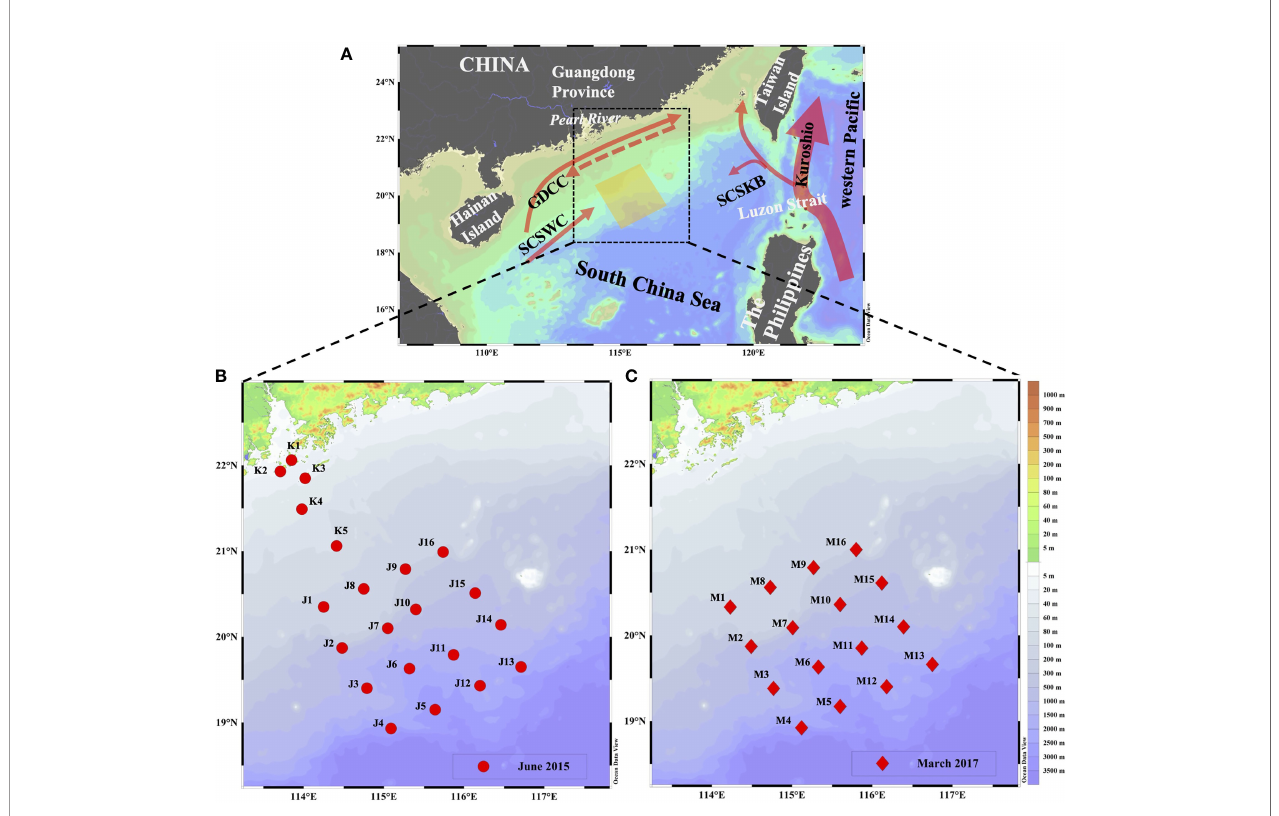
FIGURE 1 | (A) Location of our study area and water currents pattern (Hu et al., 2000) in the NSCS; distributions of sampling stations during (B) June 2015 and (C) March 2017. Red arrows represent the potential current directions, solid arrows refer to currents in the summertime and dashed arrow refers to currents in the wintertime; GDCC represents the Guangdong Coastal Current, SCSWC represent the South China Sea Warm Current and SCSBK represents the South China Sea Branch of